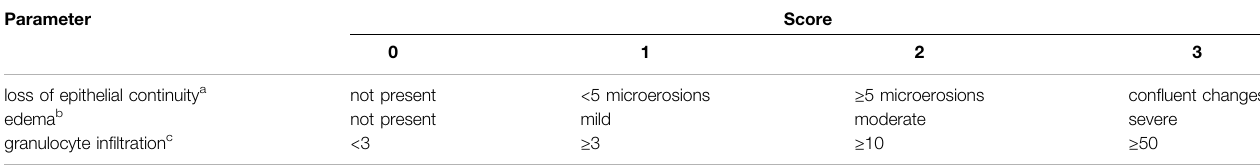
TABLE 2 | A semiquantitative score of histopathological changes in the intestine.